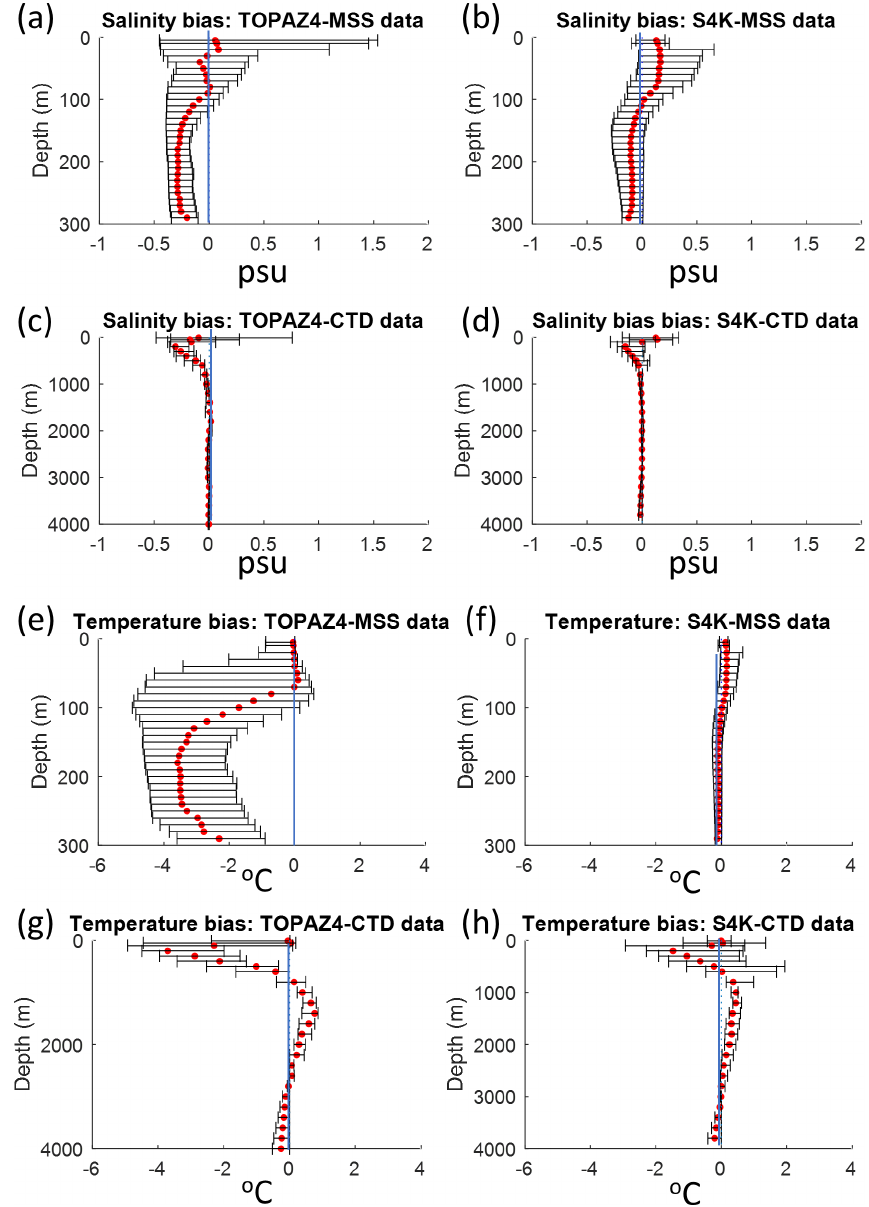
Figure 6. Salinity and temperature median bias ± 10 and 90 percentiles for TOPAZ4 (a, c, e, g) and S4K (b, d, f, h) , as a function of depth, based on data obtained during the N-ICE2015 expedition (Granskog et al., 2018). Panels (a) , (b) , (e) and (f) show biases for the upper 300m, based on data from ocean microstructure profiles (MSS) (Meyer et al., 2016). Panels (c) , (d) , (g) and (h) show biases for the whole water column, based on CTD profiles (Dodd et al., 2016) (see Fig. 1, Table 5 and text).